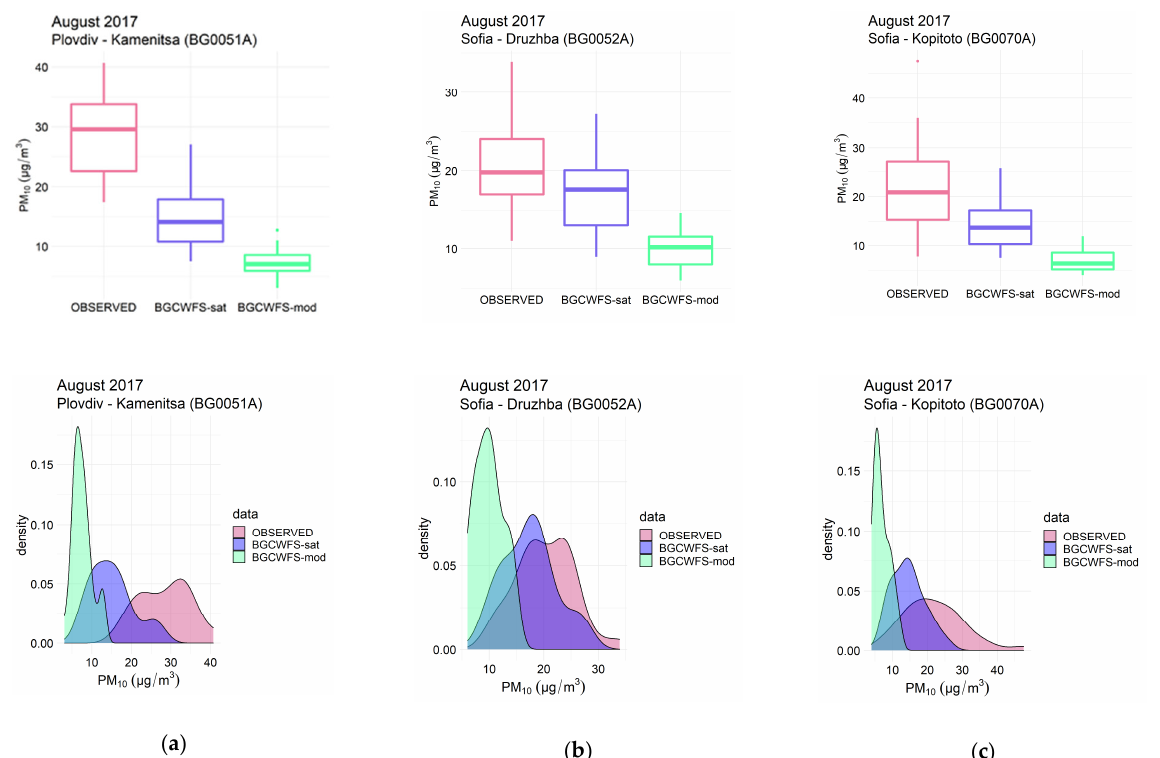
Figure 9. PM 10 in August 2017 observed, BgCWFS_sat and BgCFWS_mod and at thee selected stations: ( a ) Plovdiv Kamenitza (BG0051A); ( b ) Sofia-Drujba (BG0052A); and ( c ) Sofia-Kopitoto (BG0070A); top panels—boxplots show minimum, maximum, 25th, 50th, and 75th percentiles, bottom panels—kernel density estimations of the density distribution func- tions.